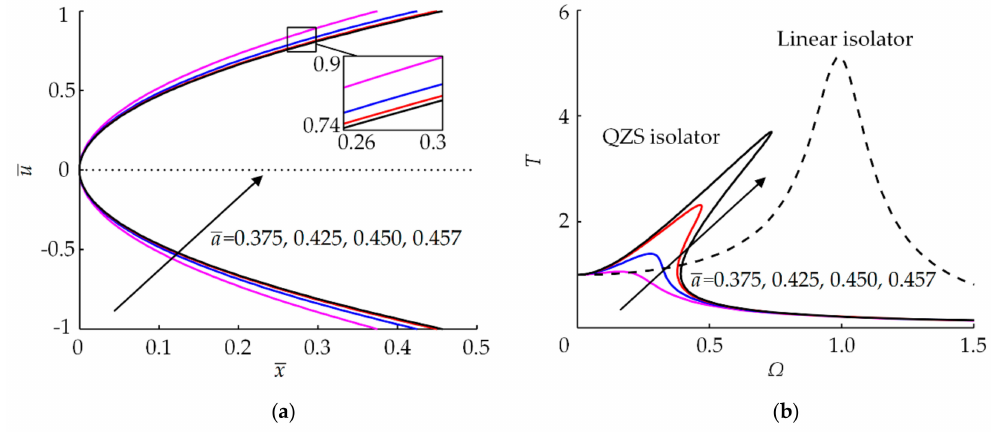
Figure 11. E ff ects of quadratic coe ffi cient a on displacement transmissibility T . ( a ) Trajectory of cam, where x = a · u 2 ; ( b ) displacement transmissibility T